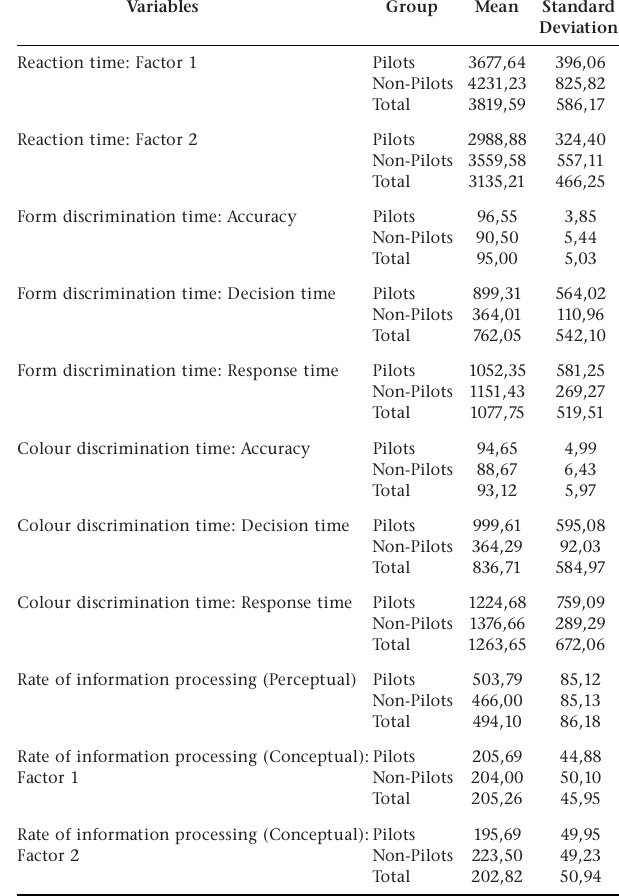
Variables Group